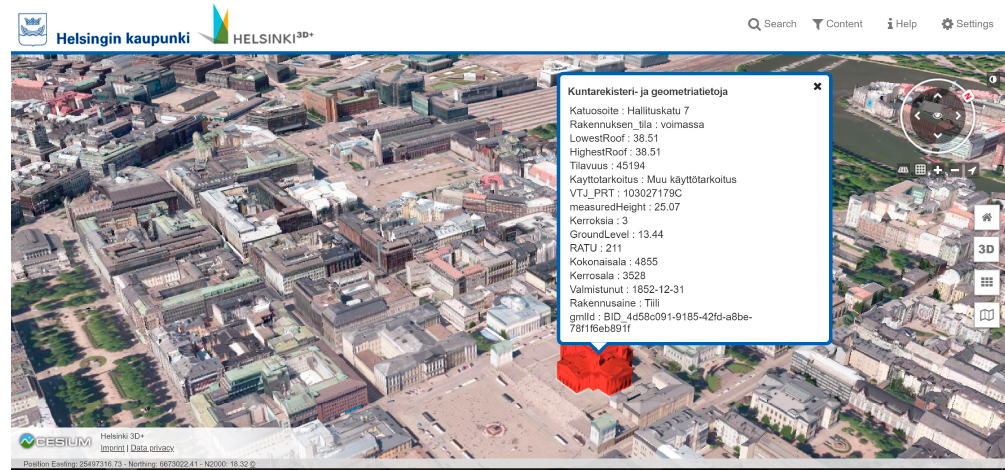
Figure 2. Helsinki 3D+ information model is the first citywide model in Finland that conforms the open CityGML standard [53].